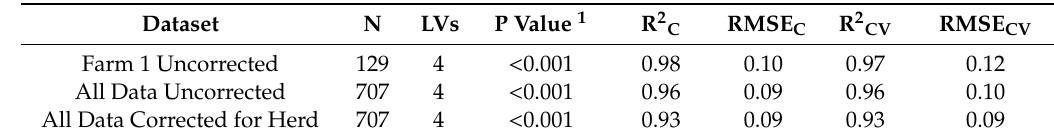
Table 4. Results obtained from 10-fold cross validation of OPLS regression models predicting serum BHBA concentration from 1 H NMR spectra using data from Farm 1 only, uncorrected data from all farms, and data from all farms corrected for the e ff ect of herd. Number of cows (N), number of latent variables included in each mode (LV), coe ffi cient of determination (R 2 ) and root mean square error (RMSE) of calibration (C) and 10-fold cross validation (CV) are shown.